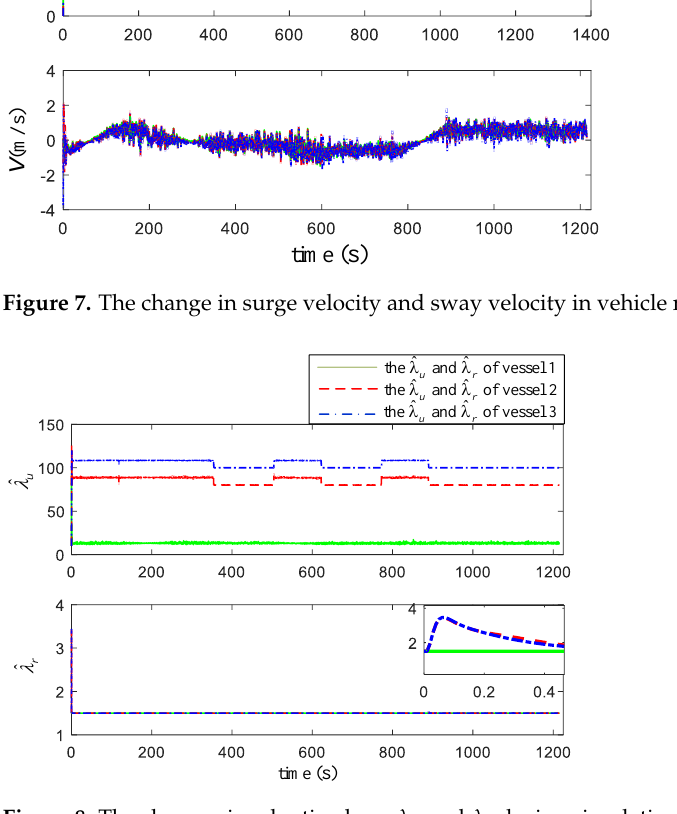
 and  and  during simulation. u r u